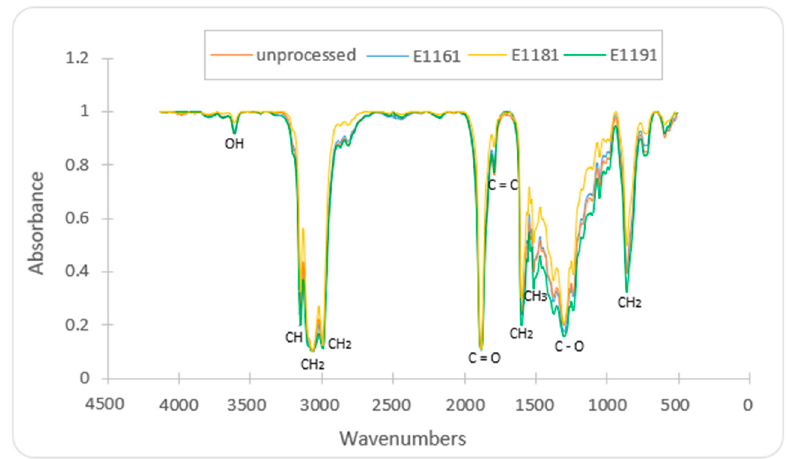
Figure 3. FTIR spectra of the sunflower oil.